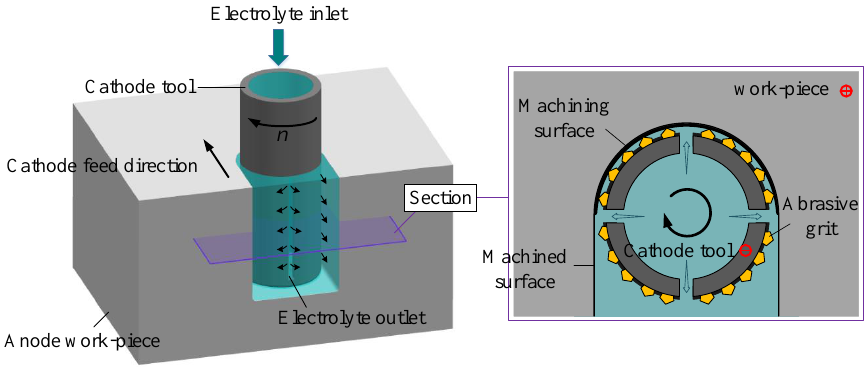
Figure 1. Schematic diagram of electrochemical mill-grinding (ECMG).